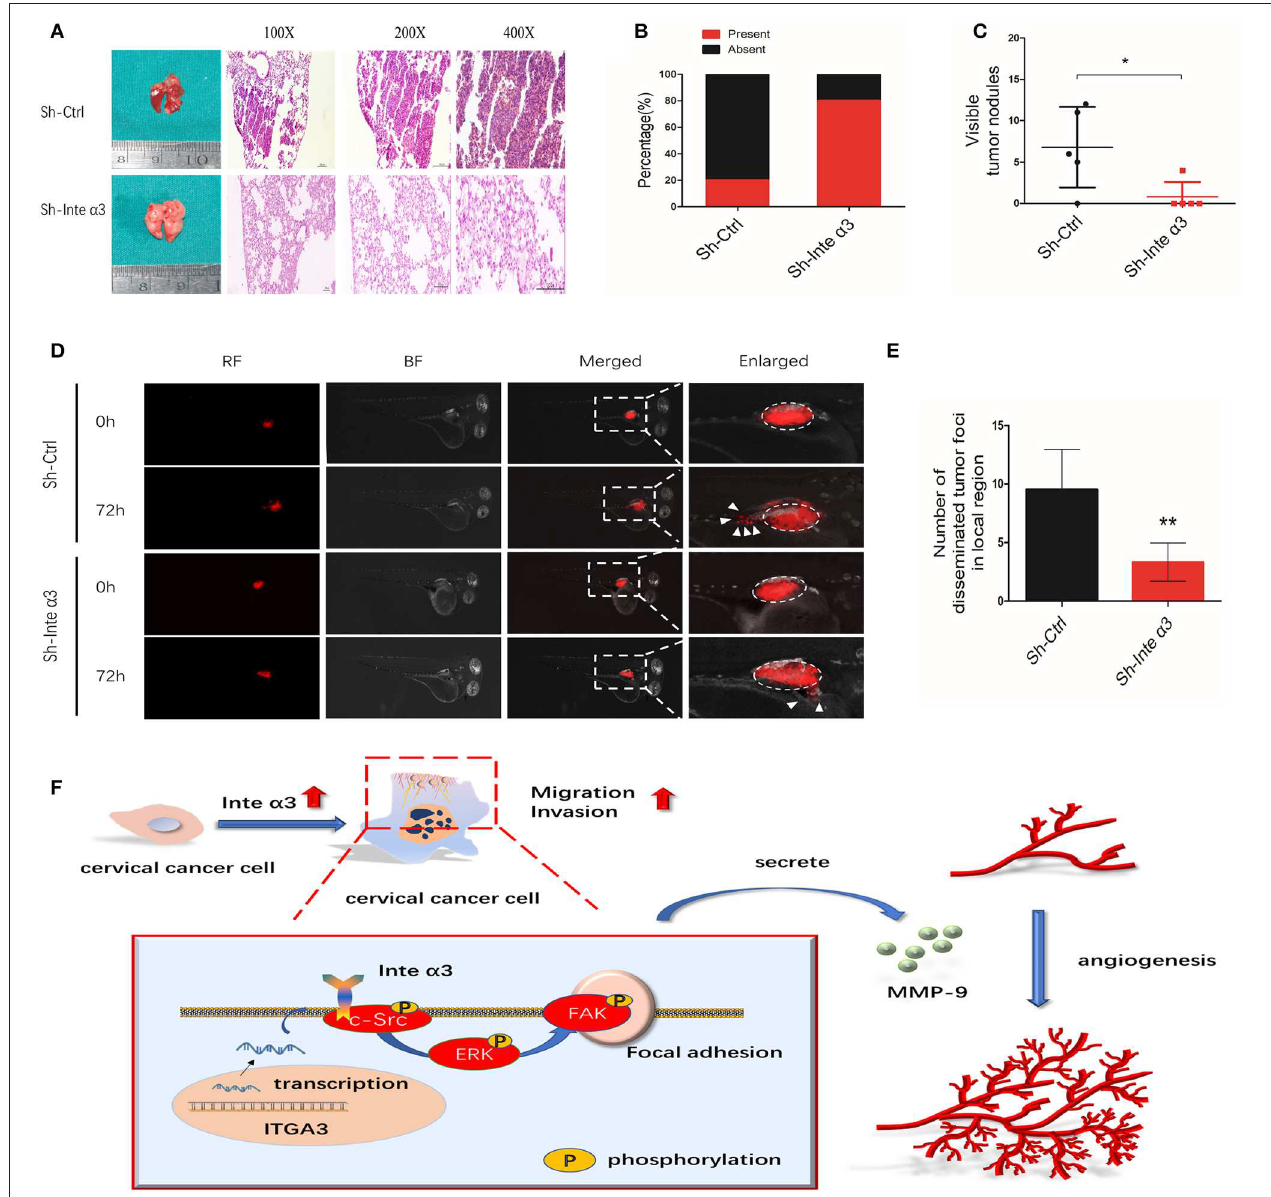
FIGURE 8 | Integrin α 3 promotes metastasis in vivo ; a proposed schematic representation of the mechanism. (A) Typical H&E images of pulmonary metastatic foci in the Sh-Ctrl group and normal pulmonary tissues in the Sh-Inte α 3 group are shown. Original magnification: × 100, × 200, and × 400. (B) Percentages of mice with or without metastatic foci in their lungs in the aforementioned two groups ( n = 5). (C) Visible tumor nodules in the lungs were calculated in these two groups. (D) The zebrafish tumor migration model was applied to explore the migration ability of cells in these two groups. (E) Quantification of the number of disseminated foci in the local region of (D) . (F) Proposed schematic representation of the mechanism demonstrating that integrin α 3 activates the c-Src/Erk/focal adhesion kinase (FAK) signaling pathway and promotes cervical cancer metastasis and angiogenesis. * P < 0.05 vs. control group; ** P <